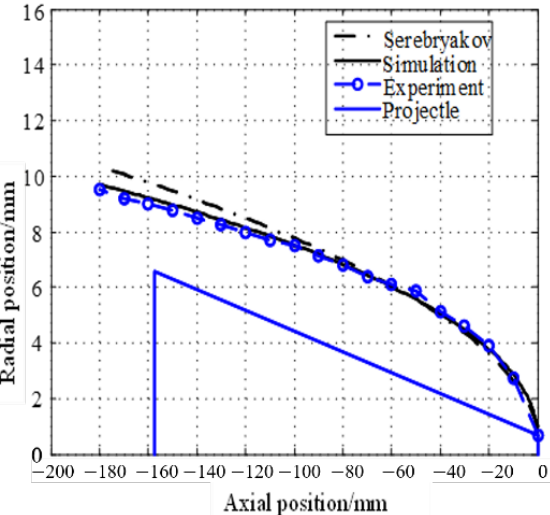
J. Mar. Sci. Eng. 2021 , 9 , x FOR PEER REVIEW Figure 6. Comparison of simulation, experiment, and theoretical calculation of cavity shape. Figure 6. Comparison of simulation, experiment, and theoretical calculation of cavity shape. Figure 6. Comparison of simulation, experiment, and theoretical calculation of cavity shape.